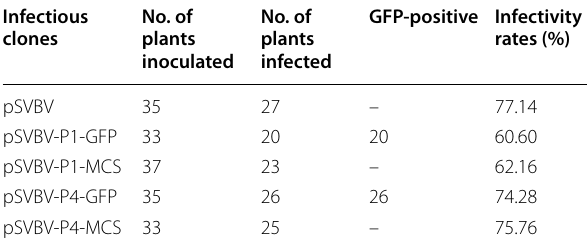
Table 1 Infectivity rates of strawberry plants inoculated with pSVBV or SVBV-based vector Infectious No. of clones